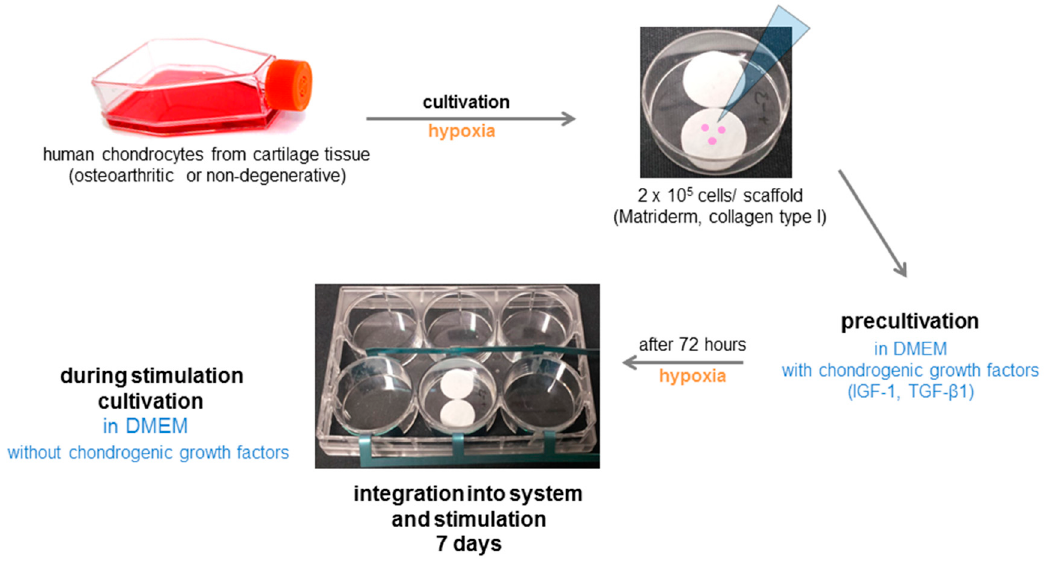
Figure 3. Scheme of the experimental procedure.